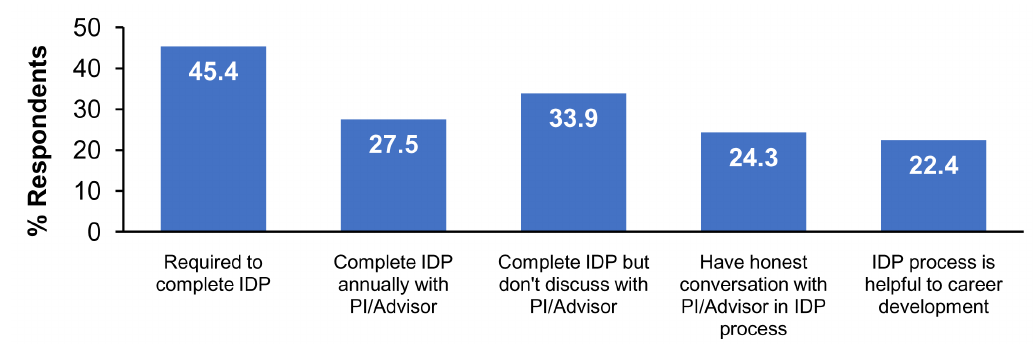
Figure 1. The rates of Individual Development Plan (IDP) use among postdoctoral researchers. Shown here are rates for variables measuring whether respondents are required to complete an IDP, complete an IDP annually with their PI/advisor, complete an IDP but do not discuss it with their PI/advisor, can have an honest conversation with the PI/advisor in context of the IDP, and whether the IDP process is helpful to their career development. One-way frequencies for all other survey variables can be found in Supplementary File